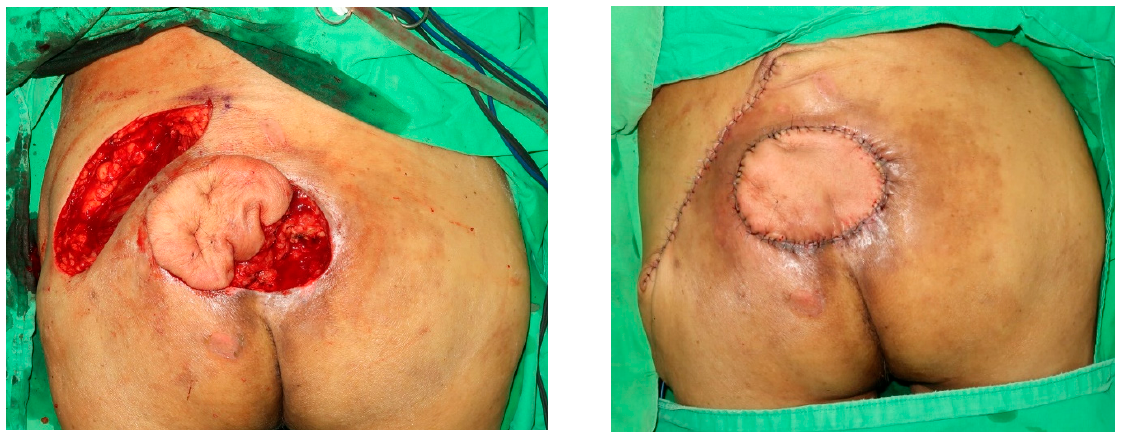
Figure 4. The SGAP flap was tunneled beneath a skin strip between the defect and the flap donor site.